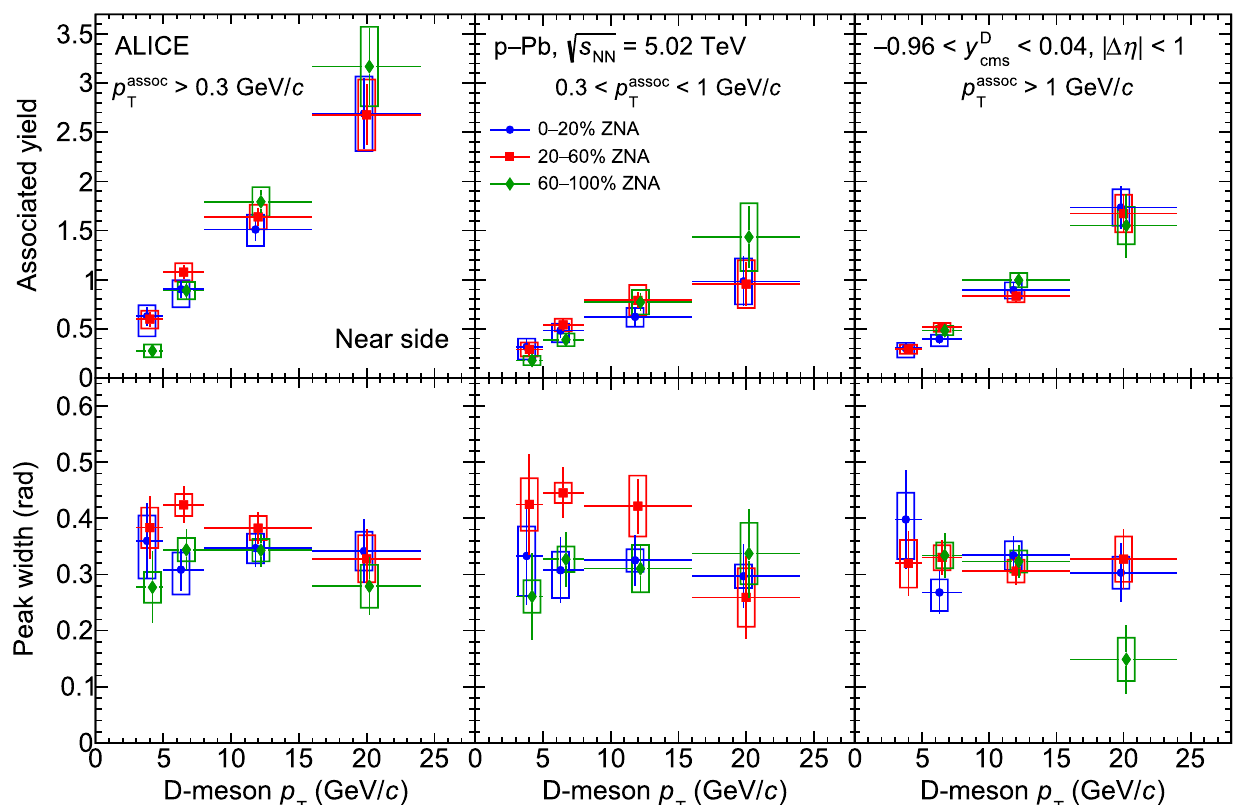
< 1 GeV / c , and p assoc > 1 GeV / c (from left to right). 0 . 3 < p assoc T T Statistical and systematic uncertainties are shown as vertical error bars and boxes, respectively. The points and error boxes for 0–20% (60– 100%) collisions are shifted by (cid:4) p T = − 0 . 2 ( + 0 . 2) GeV/ > 0 . 3 GeV / c , T